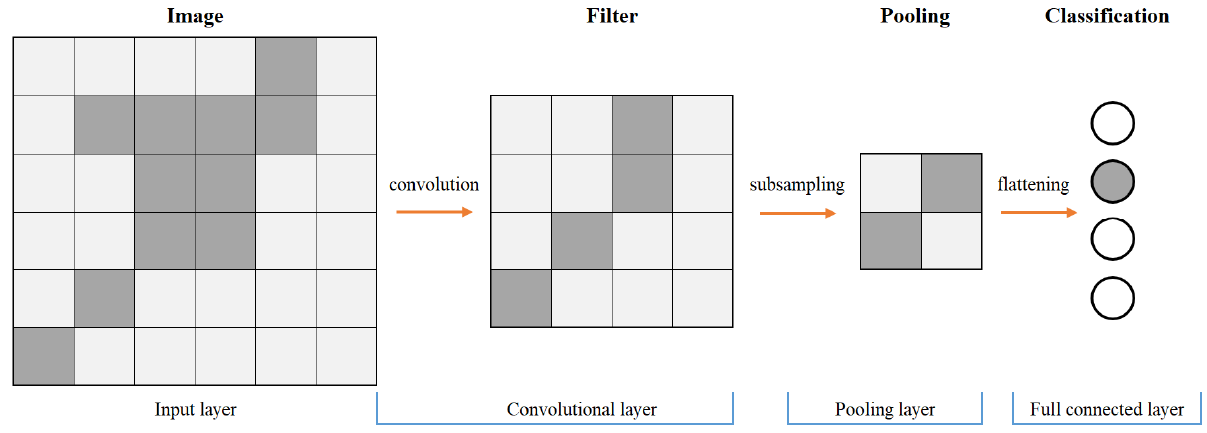
Figure 4. The traditional architecture of CNN.